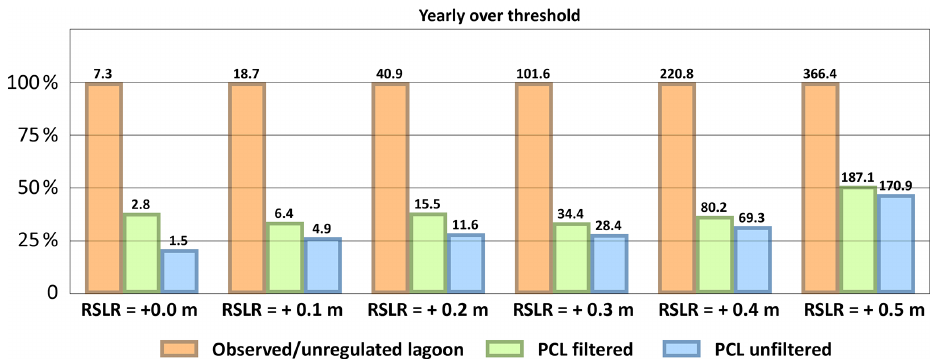
Figure 8. 2000–2019 dataset with a RSLR ranging from + 0.0m (present condition) to + 0.5m. Comparison of the annual number of closures to the increasing RSLR. Orange bars illustrate the total number of SL peaks over threshold, green bars the residual events over threshold by implementing the PCL under the filtered scenario, and blue bars the residual events if the PCL will be implemented during all the SL